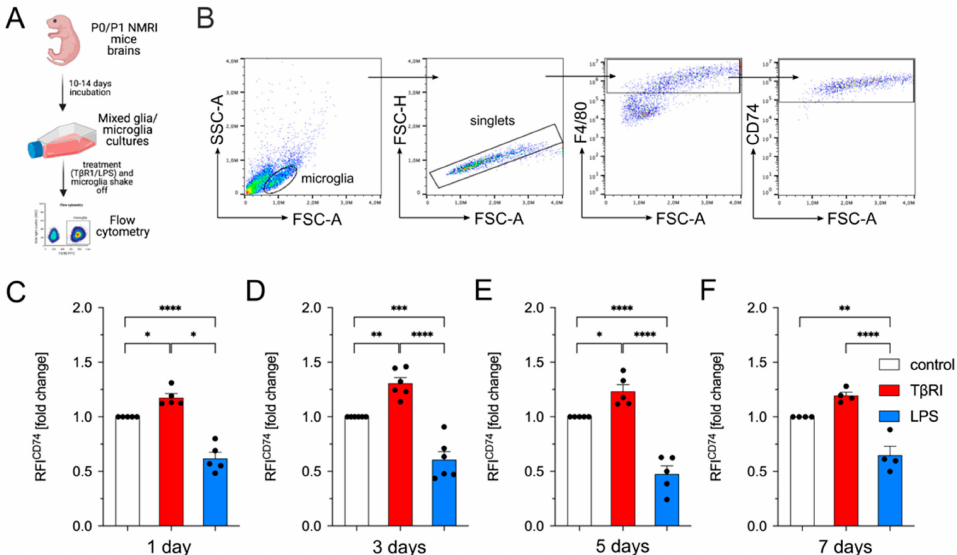
Figure 5. Inhibition of TGF β signaling increases surface expression of CD74 in microglia. ( A ) Scheme of experimental workflow for flow cytometry, created with BioRender.com. ( B ) Gating strategy to detect CD74 surface expression in F4/80 + microglia. Relative fluorescence intensities (RFI) of CD74 in microglia (out of F4/80 + cells) were analyzed after 1 ( C ), 3 ( D ), 5 ( E ), and 7 days ( F ). ( C – F ) Quantifications and statistical analyzes of relative fluorescence intensities (RFI) of CD74 after indicated treatments and time points. Data are given as means ± SEM for at least three independent experiments. p -values derived from one-way ANOVA followed by Tukey’s multiple comparison tests are shown as follows: * p < 0.05, ** p < 0.01, *** p < 0.001, and **** p <